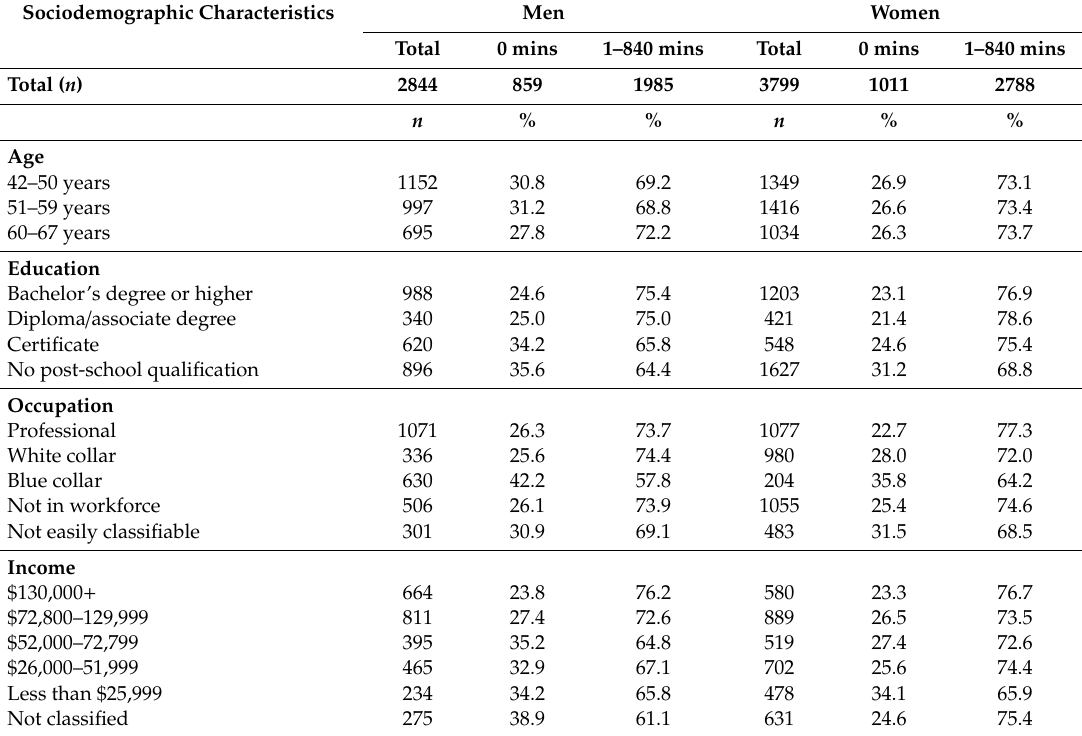
Table 1. Sociodemographic characteristics of the analytic sample by gender and minutes of recreation walked: 2009 HABITAT